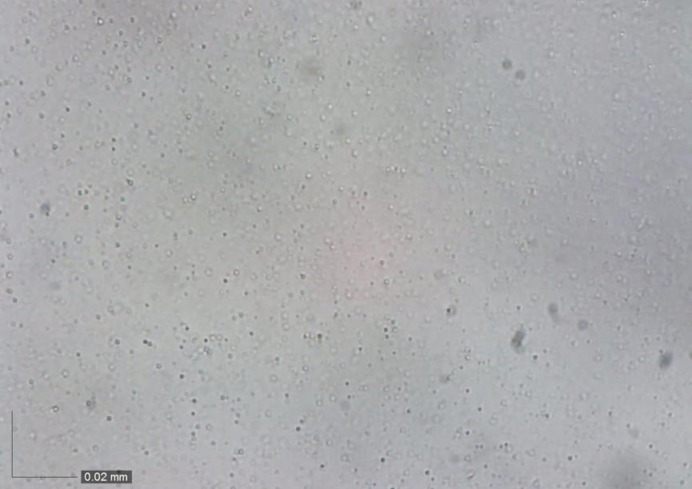
Optical microscopy image of crude O/W of the 7th day.